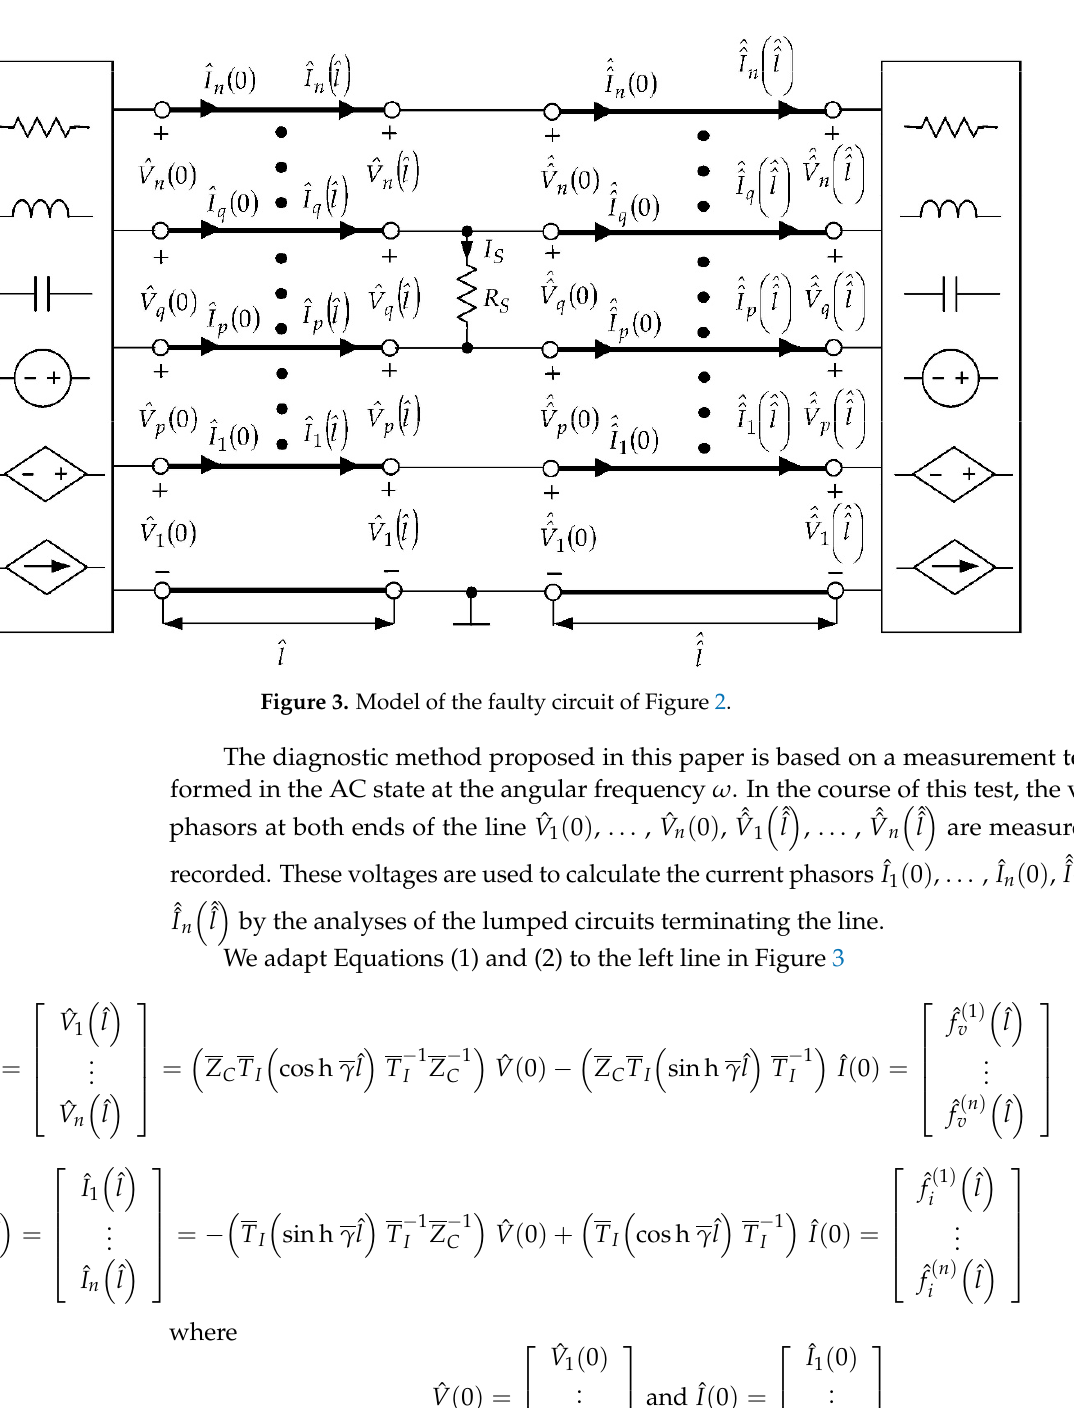
4 of 18 Figure 2. Circuit including ( n + 1)-conductor transmission line. 3. Soft Short Fault Diagnosis